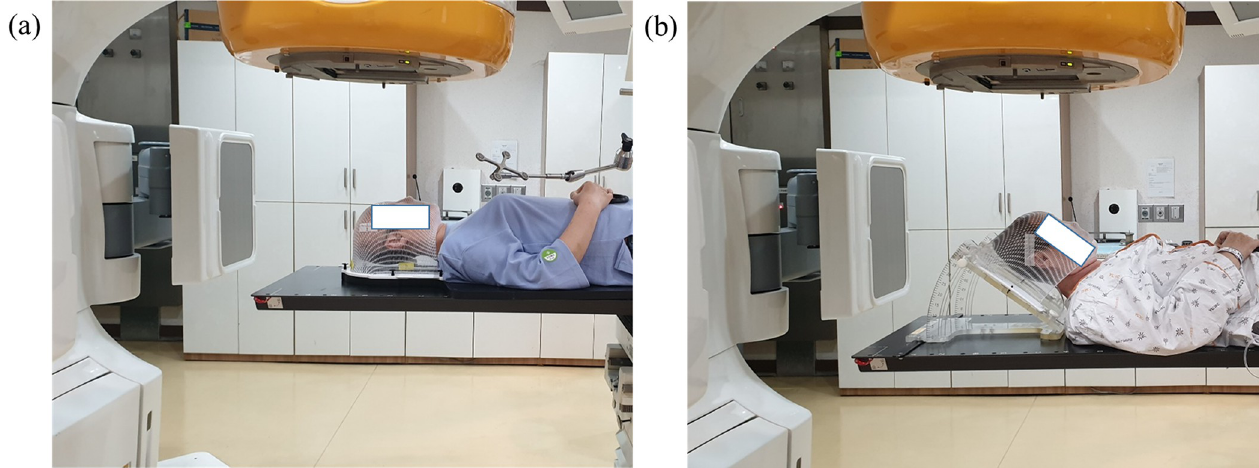
Fig 1. Patient setup position for radiotherapy. (A) supine position, (B) head-tilted supine position.